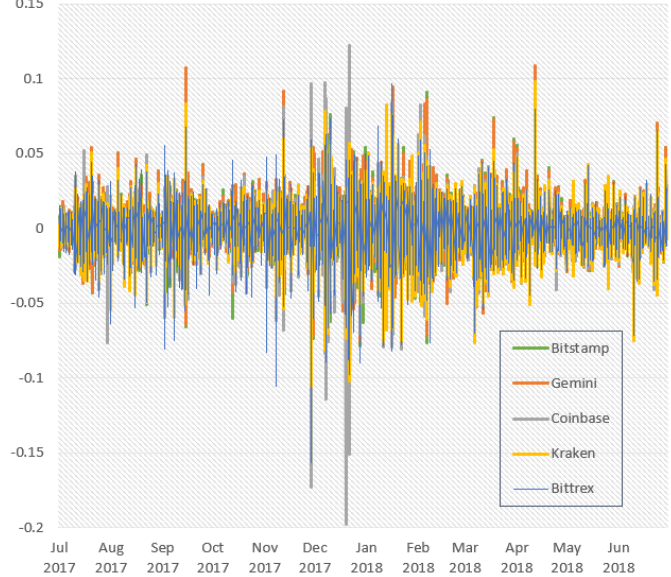
Figure 2. Exchange continuous returns. Note : The figure illustrates the analyzed Bitcoin exchange continuous returns during the sample period 1 July 2017–30 June